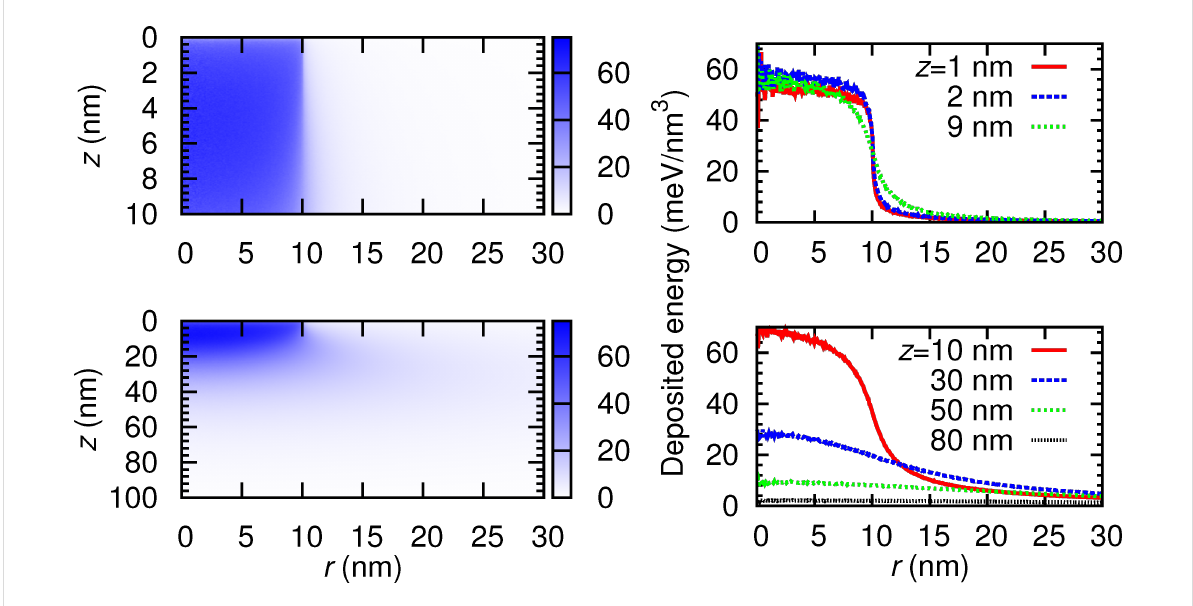
Figure 13: Distribution of energy deposited in WC 1.75 O 0.75 as a function of the depth z and the radial coordinate r . The two upper (lower) panels correspond to a sample thickness d WCO = 10 nm ( d WCO = 100 nm). The right-hand-side panels display cross sections of the distribution at the indi- cated depths z below the deposit-vacuum interface.